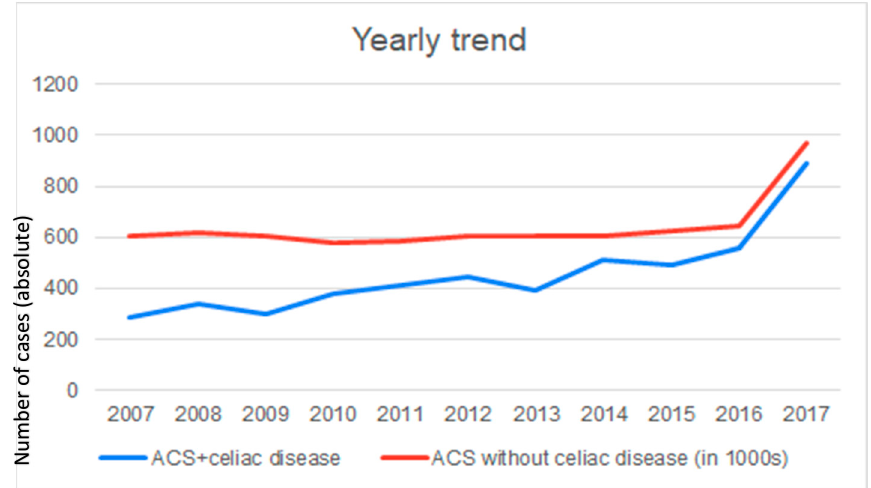
Figure 1. Yearly trend of ACS in celiac disease patients compared to non-celiac disease. (y axis is number of cases; in 1000 for ACS with no celiac disease).